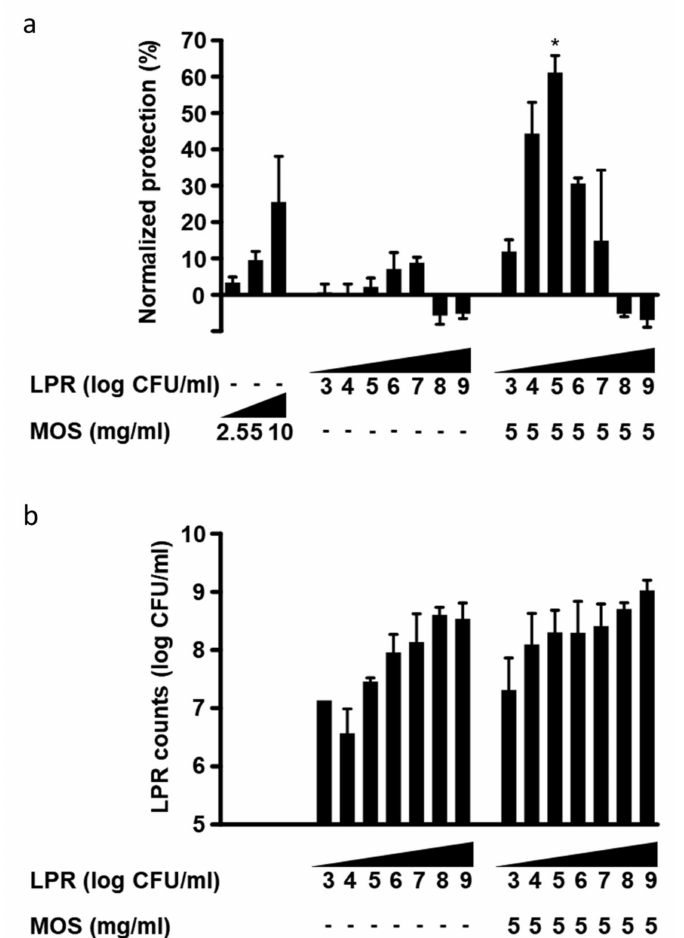
Figure 3. ( a ) Protection of T84 epithelial cells from barrier integrity damage by C. di ffi cile toxin A. T84 cells were preincubated for 2 h with MOS, in the absence or presence of 10 3 to 10 9 / mL L. rhamnosus (LPR) prior to the addition of C.di ffi cile toxin A. T84 transepithelial resistance was measured before sample addition and after 20 h in the presence of toxin A. Protection of resistance was normalized to that of T84 in media alone (0%) and MRS (100%). Data are expressed as mean ± SEM, n = 3 independent experiments, except LPR at 10 4 , 10 6 , 10 8 / mL ( n = 2), independent experiments with n = 2 replicates each. Statistical di ff erence from LPR alone plus MOS alone is indicated * p < 0.05. ( b ) Concentration of LPR after incubation for 20 h on T84 cells in absence or presence of 5 mg / mL MOS and at di ff erent initial inoculation concentrations from 10 3 to 10 9 cfu / mL. Data are expressed as mean ± SEM, n ≥ 2 independent experiments with n = 2 replicates each. Statistical di ff erence to corresponding LPR concentration without MOS by unpaired t-test is indicated * p <